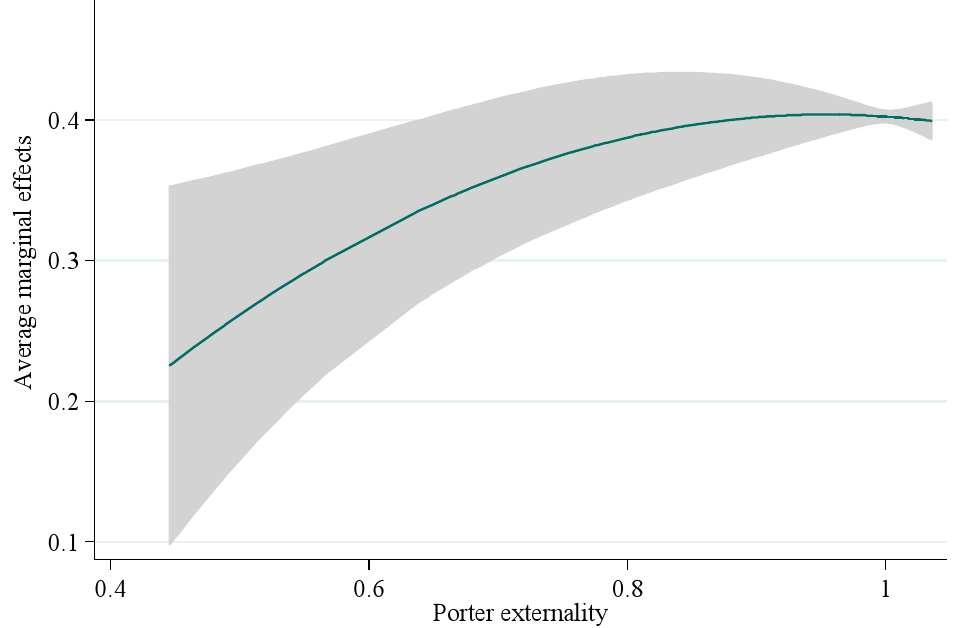
Figure 5. The average marginal effects of the Porter externality.